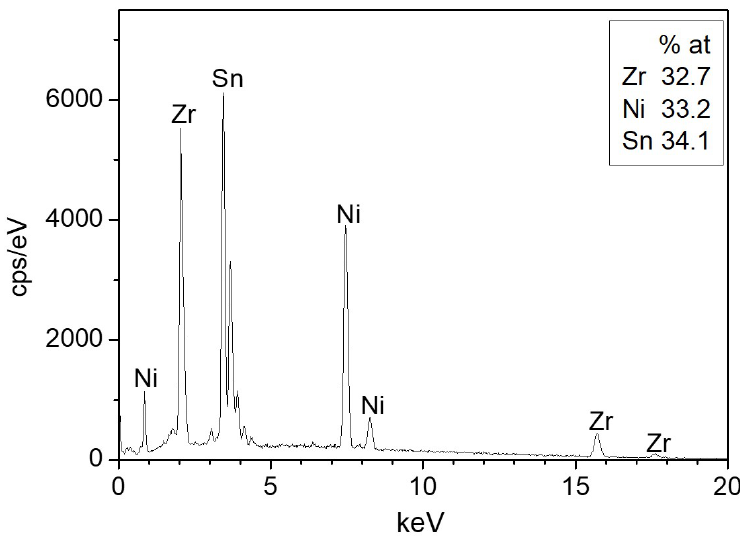
Figure 1. Representative energy dispersive spectroscopy (EDS) spectrum of the sample surface.